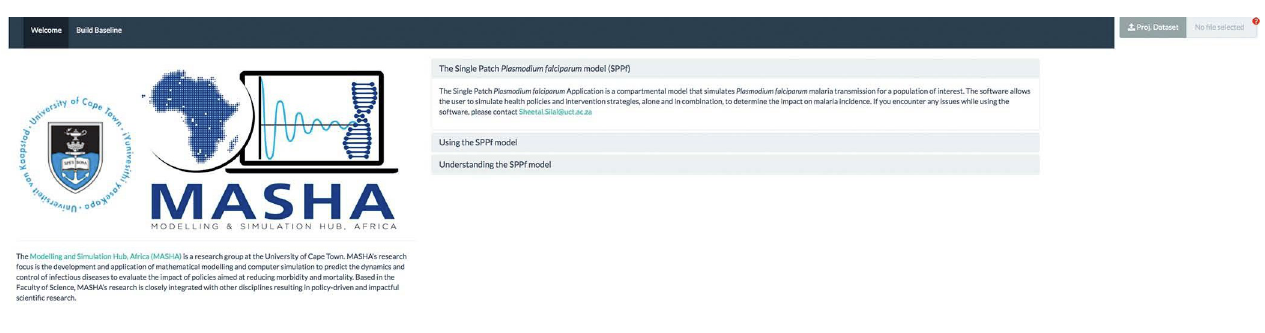
Fig 1. Dashboard of the single patch Plasmodium falciparum model interface in